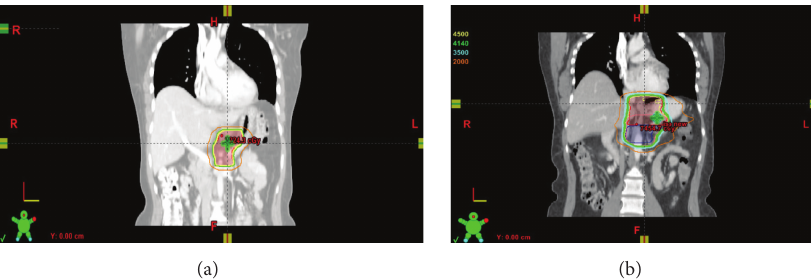
Figure 2: Palliative and reirradiation treatment to the abdomen. (a) Initial palliative radiation treatment to the gastrohepatic nodal region with corresponding isodose lines. (b) Reirradiation to the abdomen including the GEJ primary showing cumulative dose with corresponding isodose